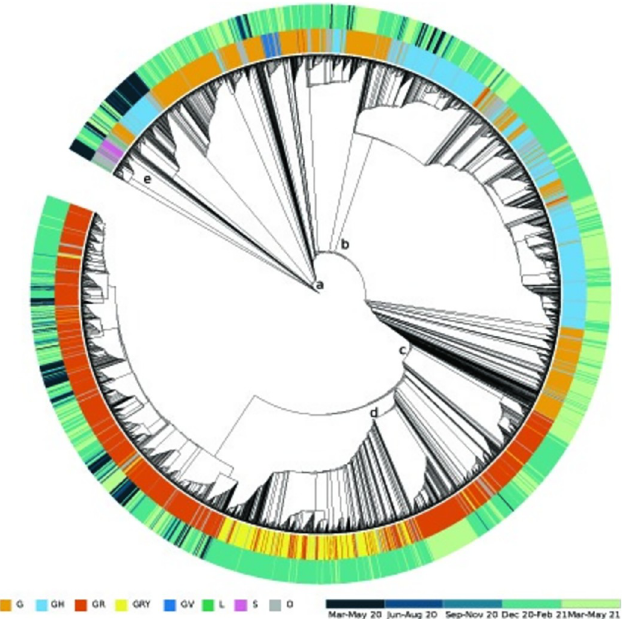
Fig 4. Circular representation of the phylogenetic tree of 4607 viral genomes from Turkey. The inner circle defines GISAID clades with different colors for each individual data point. The outer circle defines the timelines of the collection of data and each time period is represented by different color codes. The branches of the main clades that were discussed in the manuscript are represented by letter codes (a) Main branch of G clade, (b) GH clade, (c) GR clade, (d) GRY clade, and (e) the branch of the genome sequences of 13 patients in our center.